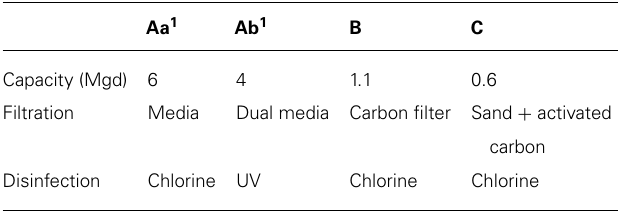
Table 1 | Summary of reclaimedWWTP tertiary treatment